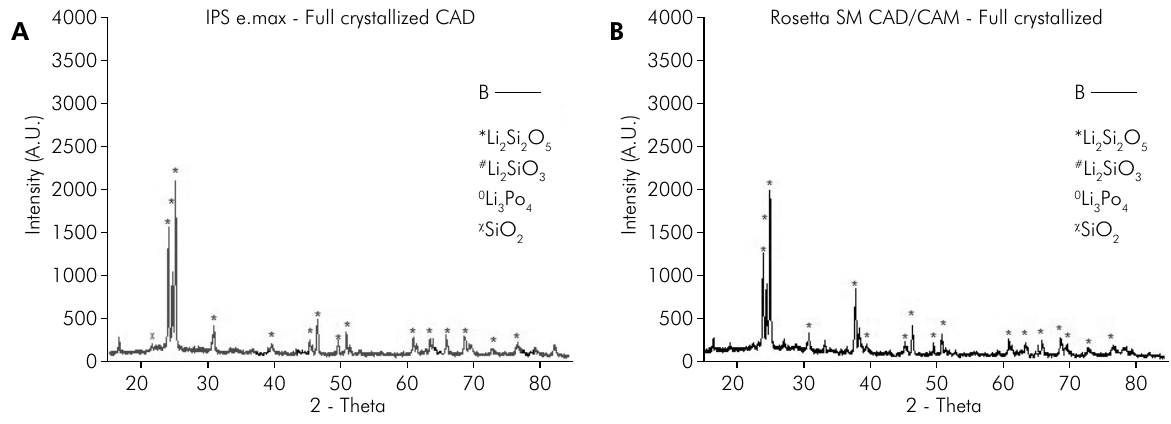
Figure 1. XDR patterns: A: IPS e.max CAD group; B: Rosetta SM group.